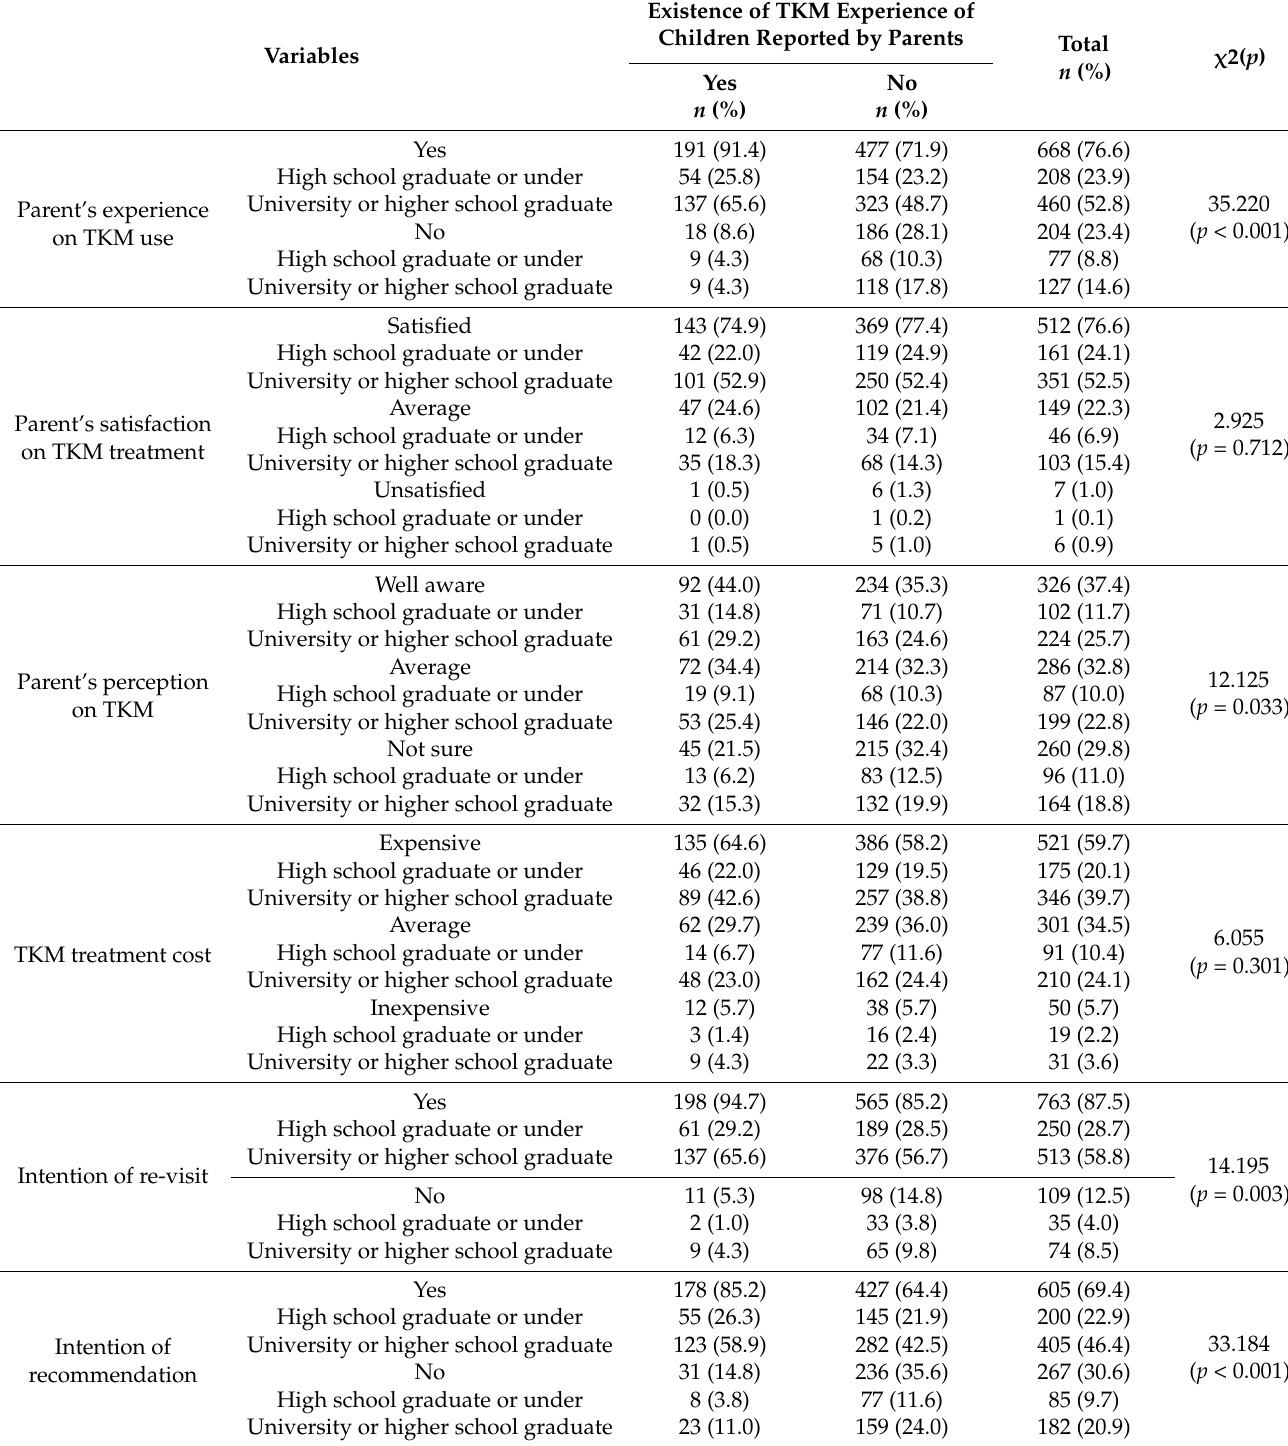
Table 3. Perception of the survey respondents with and without TKM experience of children. Existence of TKM Experience Variables